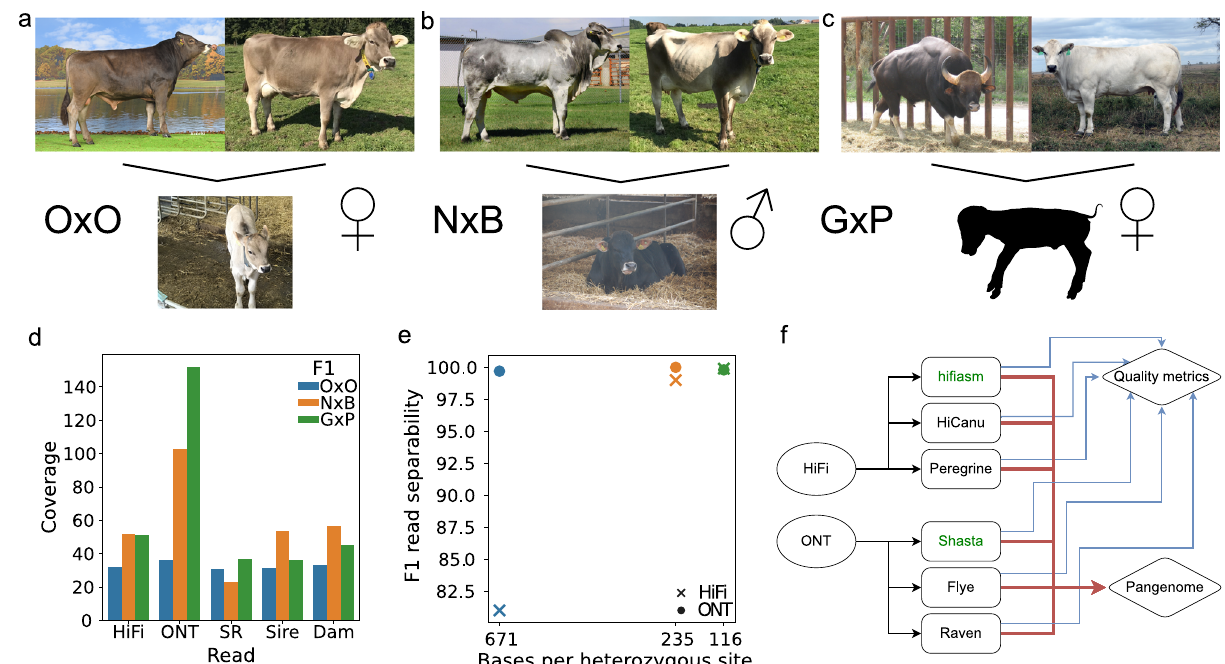
Fig. 1 Overview of bovine trios. a – c Representative animals for the parents of the three bovine trios and the respective F1s (OxO, NxB, and GxP) examined in this study. The OxO and GxP were female, while the NxB was male. d The three respective F1s were sequenced to 32-, 52-, and 51- fold HiFi coverage, with read N50 of 20, 21, and 14 Kb. ONT sequencing was performed to 36-, 103-, and 152-fold coverage respectively, with read N50 of 65, 45, and 49 Kb. Coverage is determined with respect to an assumed genome size of 2.7 Gb. F1 short reads (SR) were collected to 31-, 23-, and 37-fold coverage. e Separating F1 reads into parental haplotype bins improved with increasing heterozygosity for HiFi, but F1 reads were nearly 100% separable for ONT even at low heterozygosity (color from panel d ). f HiFi reads were assembled with hi fi asm, HiCanu, and Peregrine, while ONT reads were assembled with Shasta, Flye, and Raven. Green font indicates the tools used to produce the assemblies that are discussed in detail. Assemblies were assessed individually for quality metrics (blue lines) as well as integrated together into pangenome analyses (red lines).